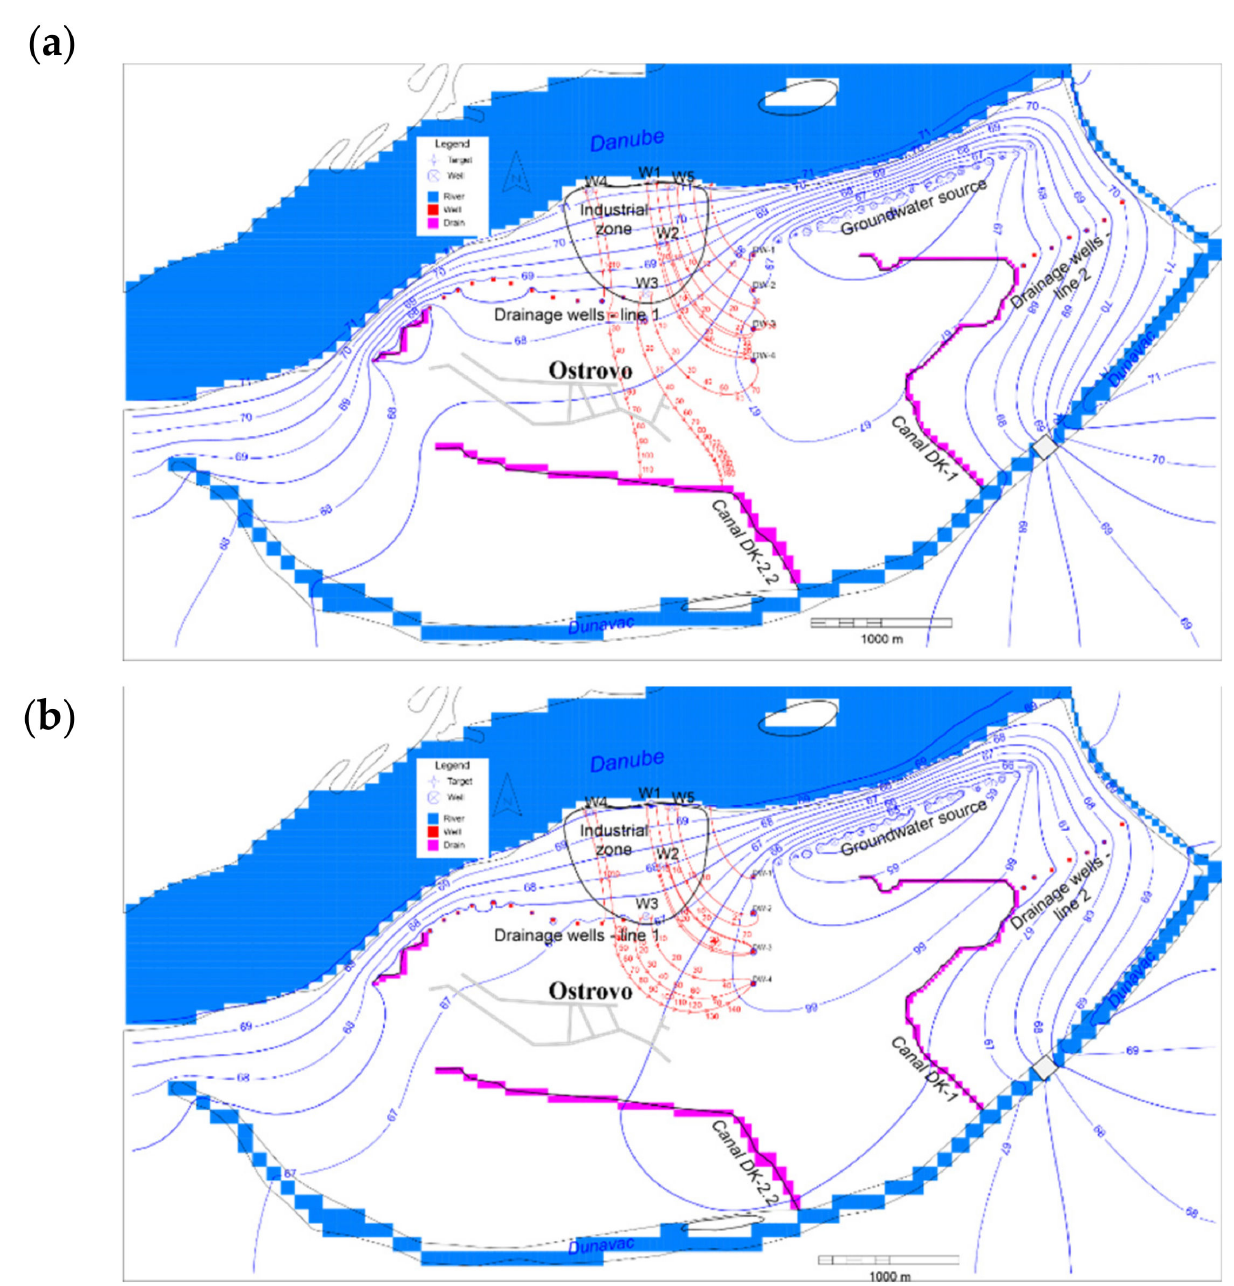
Figure 16. Flow pattern of Plan 1 (drainage wells) at the ( a ) high and ( b ) low stages of the Danube recorded in 2015 (second model